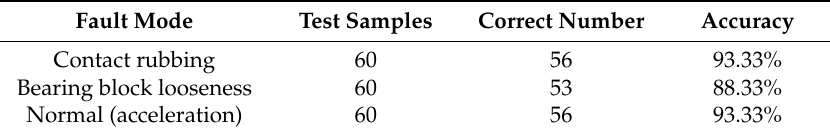
Table 3. Diagnosis result and correct rate using acceleration CNNs.